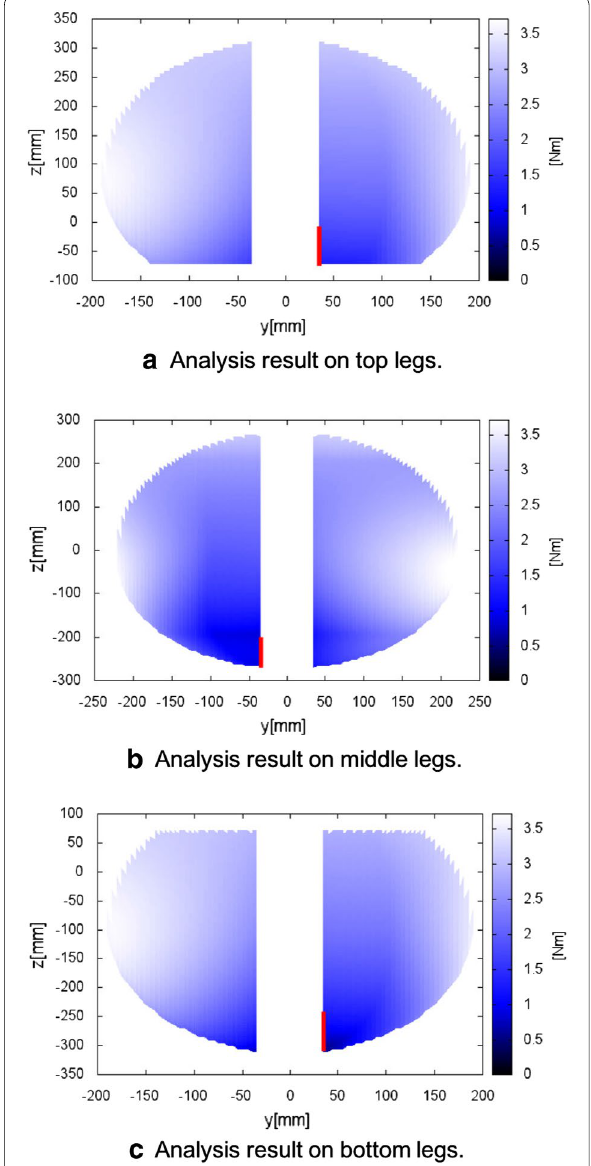
Fig. 11 Evaluation function values according to contact point a Limb from pair 1, b Limb from pair 2, c Limb from pair